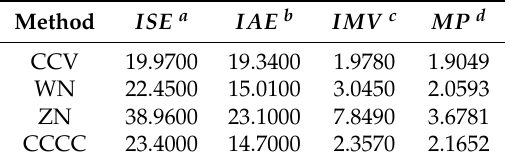
Table 6. Scores. Disturbance rejection for the set P 4 .